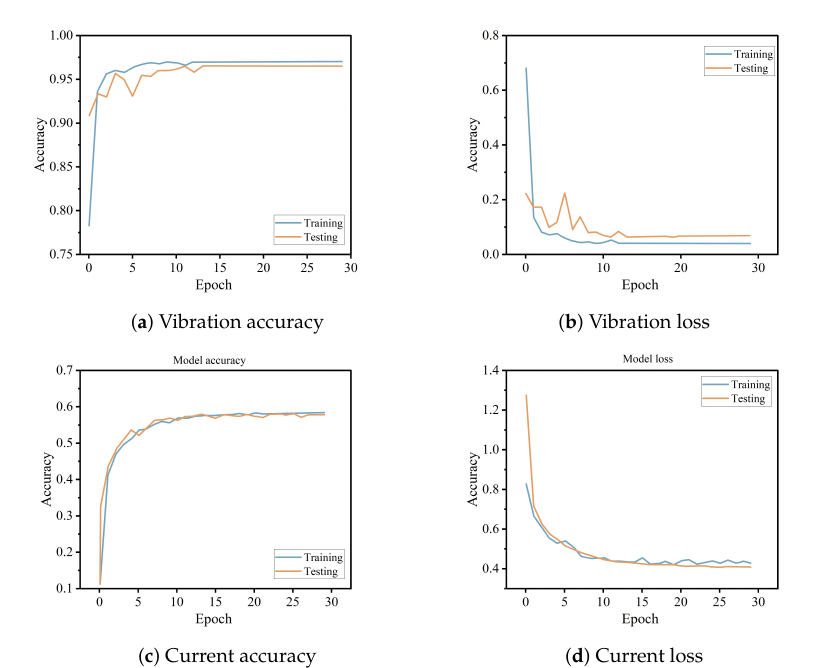
Figure 10. Model accuracy and loss for single-signal